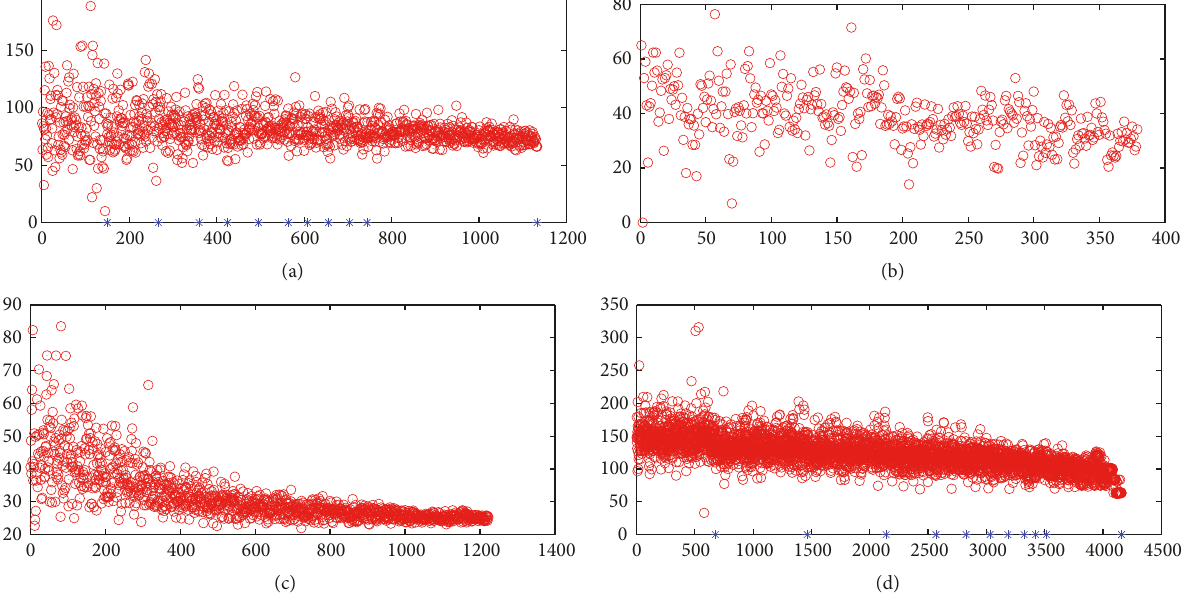
Figure 8: The time when each node terminates propagation on (a) Email-URV, (b) Netsci, (c) PolBlogs, and (d) Ca-GrQc, respectively. The nodes in the higher layer terminate propagation and become Stiflers